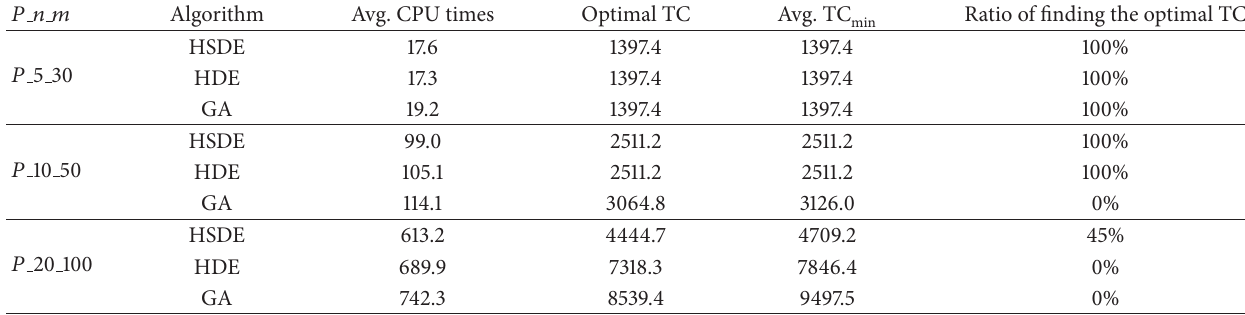
Table 6: Comparison of the results for different scales.